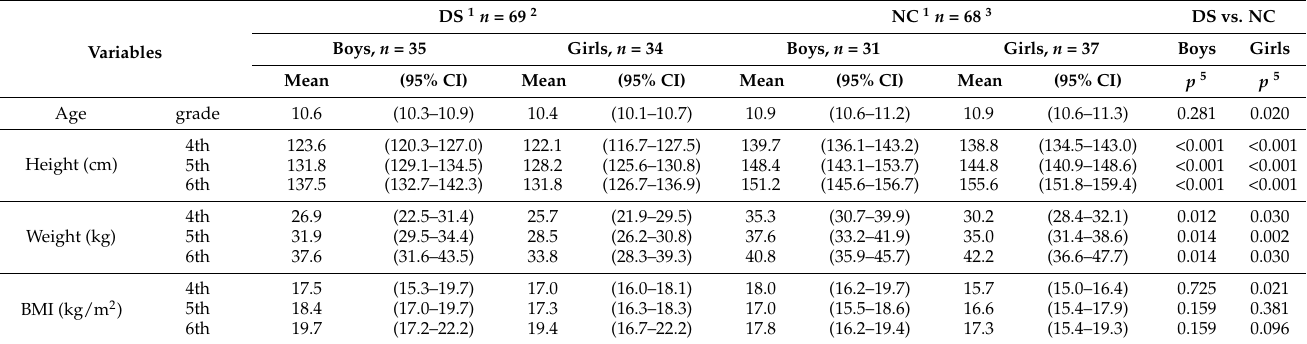
Table 1. Study participants’ attributes and physical